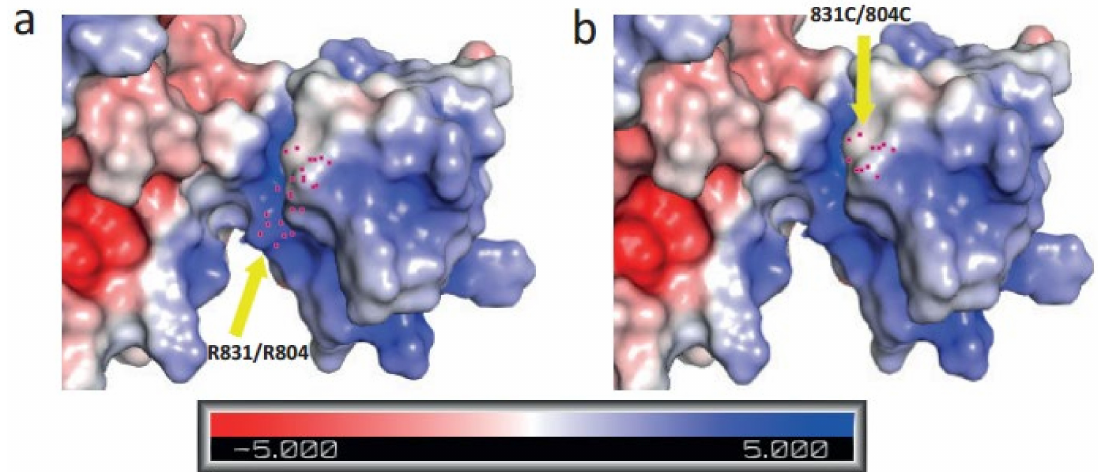
Figure 8. ( a ) An electrostatic potential surface of wildtype solute carrier family 4, sodium borate transporter, member 11 protein indicating amino acid residue ARG at position 831/804. ( b ) An electrostatic potential surface of mutant-type protein indicating amino acid residue CYS at position 831/804. In the colour legend, the red colour indicates negative potential, the blue colour indicates positive potential of the protein surface and the white regions correspond to fairly neutral potentials. Yellow arrow indicates towards the mutation site at position